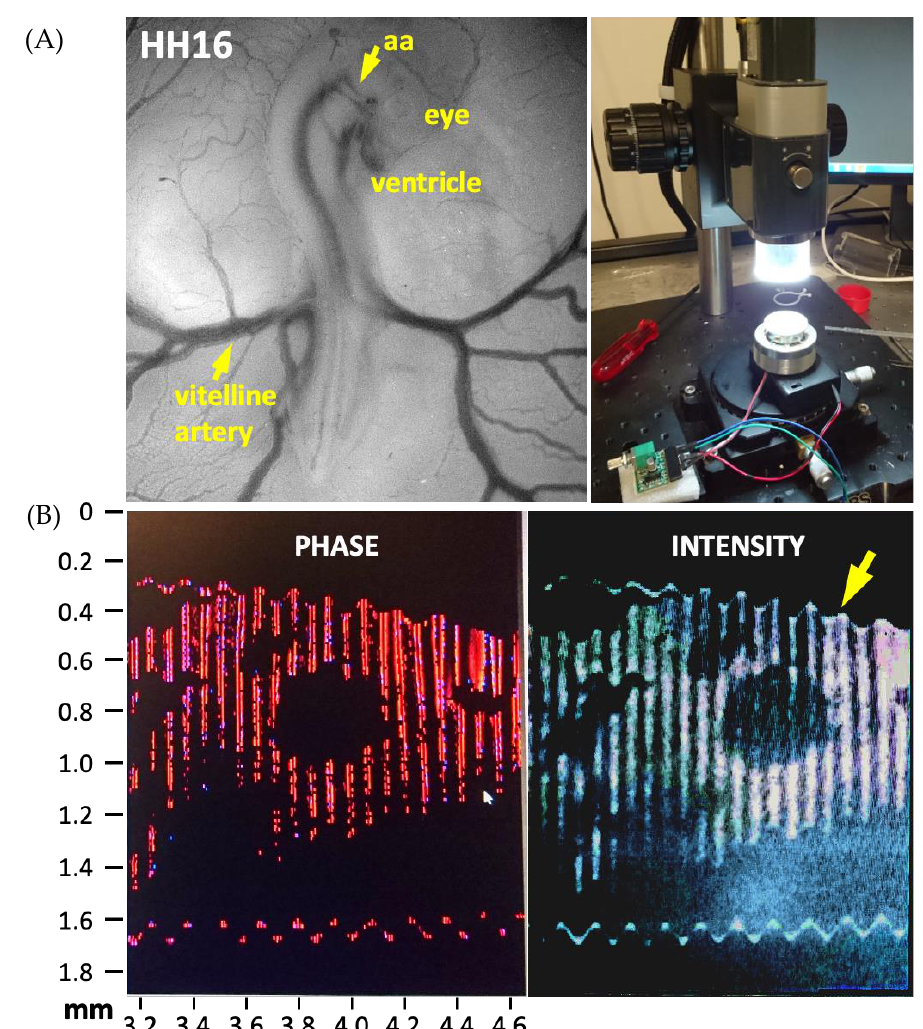
Figure 1. The experimental setup used to evaluate material properties in chick embryos at HH16 (vitelline artery) to HH24 (aortic arch, aa) is shown on the right. ( A ). Stage HH16 chick embryo imaged under a stereomicroscope is also provided. ( B ). Preliminary optical coherence tomography images of chick ventricle during acoustic forcing (0–20 kHz) performed for noninvasive elastography. A cross-section of the ventricle is displayed. The arrow points to the instantaneous deformation of the soft tissue.